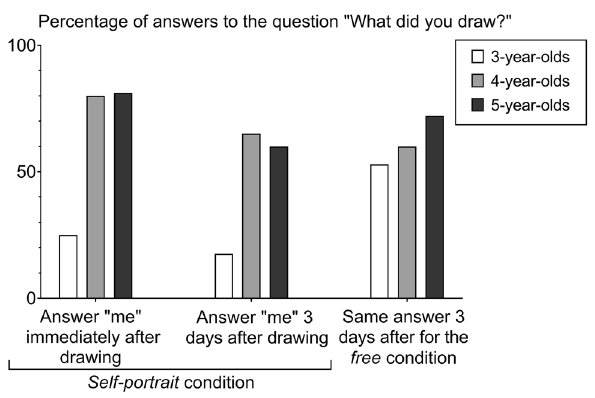
Figure 4. Percentages of answers given by children of 3, 4, 5 years old to the question “What did you draw?” for the self-portrait condition and for the free